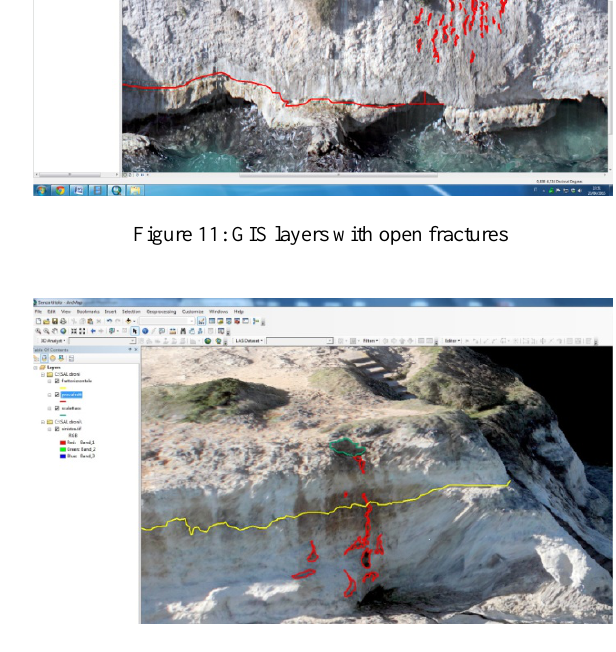
Figure 12. Unevenness line (yellow), fractures (red) and crumbling mass (green)